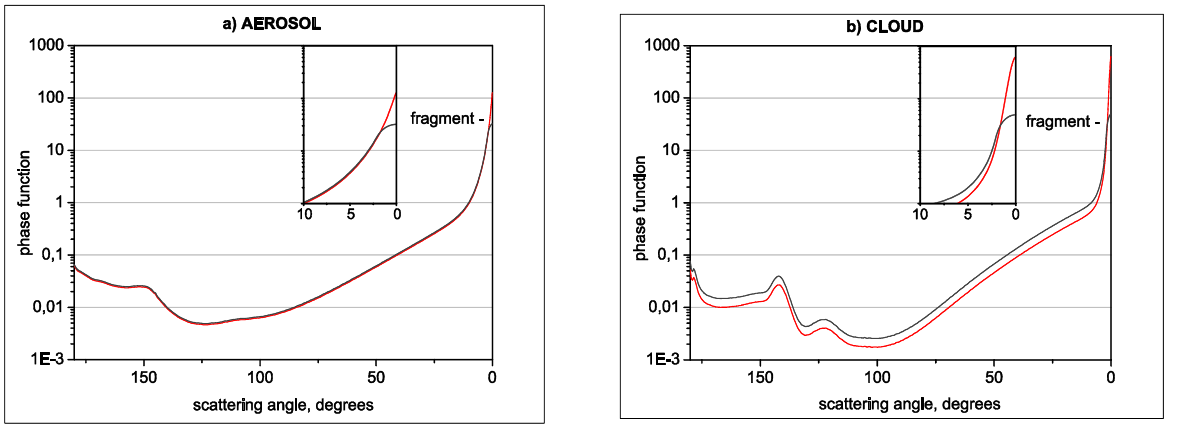
Figure 5. Phase functions of the aerosol ( a ) and cloud ( b ) models used in this work: initial (from (Kokhanovsky et al. , 2010) [9]) and after cutting-off a strong forward